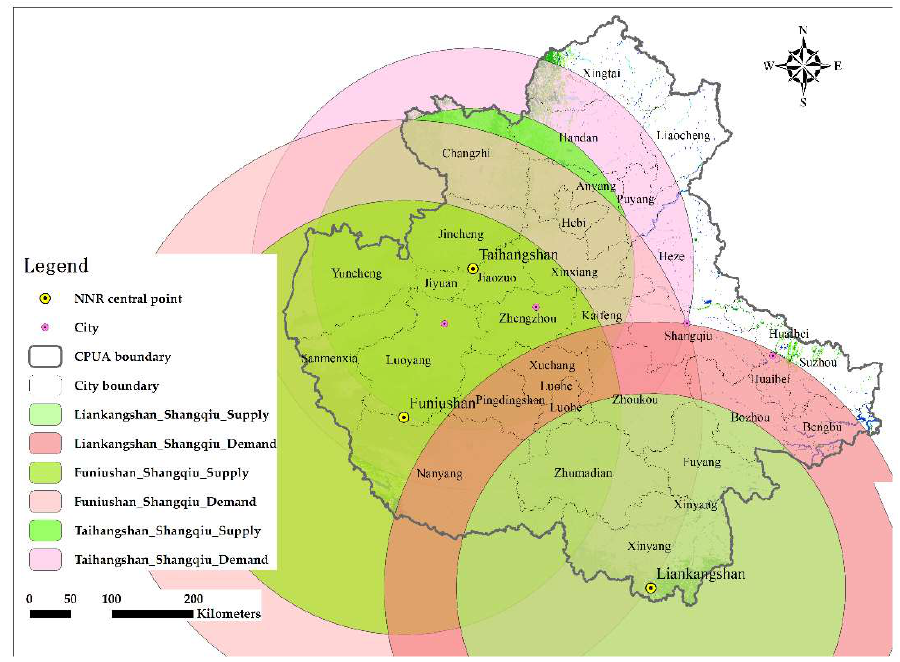
Figure 4. ES supply and demand patterns based on spatial transfer from ecospace to Zhengzhou.